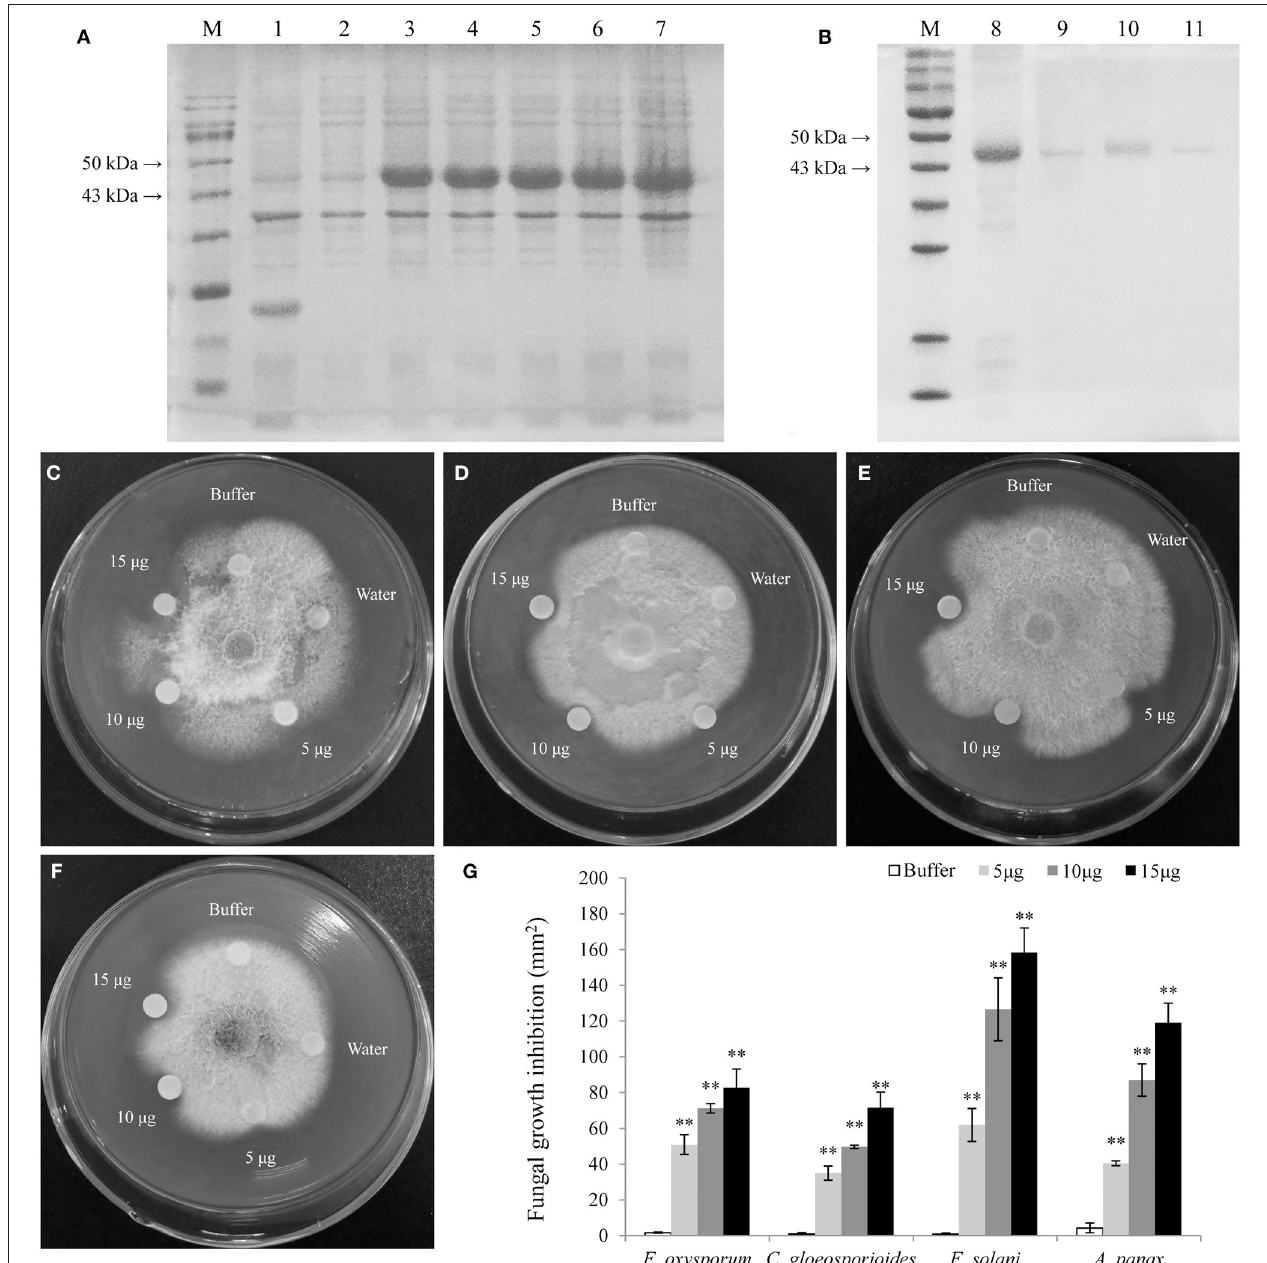
FIGURE 6 | Expression, purification, and antifungal assay of LrCHI2 recombinant protein. (A) The induced expression of LrCHI2 recombinant protein under 1mM IPTG condition. M, protein marker; Line 1, the protein of E. coli with empty vector pET-32a was detected after induction; Line 2, the expression of LrCHI2 protein was detected without induction; Line 3-7, the expression of LrCHI2 protein was detected at 6, 8, 10, 12, and 24h after induction, respectively. (B) The purification of LrCHI2 recombinant protein. M, protein marker; Line 8, the supernatant after treatment with the inclusion body solubilizing solution; Line 9-11, the purified LrCHI2 recombinant protein with 50, 100, 150mM imidazole washing buffer, respectively. (C–F) The LrCHI2 recombinant protein has evident antifungal activity to F. oxysporum (C) , C. gloeosporioides (D) , F. solani (E) and A. panax (F) . (G) The fungal growth inhibition areas (mm 2 ). Bars represent the standard errors of three biological replicates. The statistical analysis was performed with the t test (** p < 0.01).